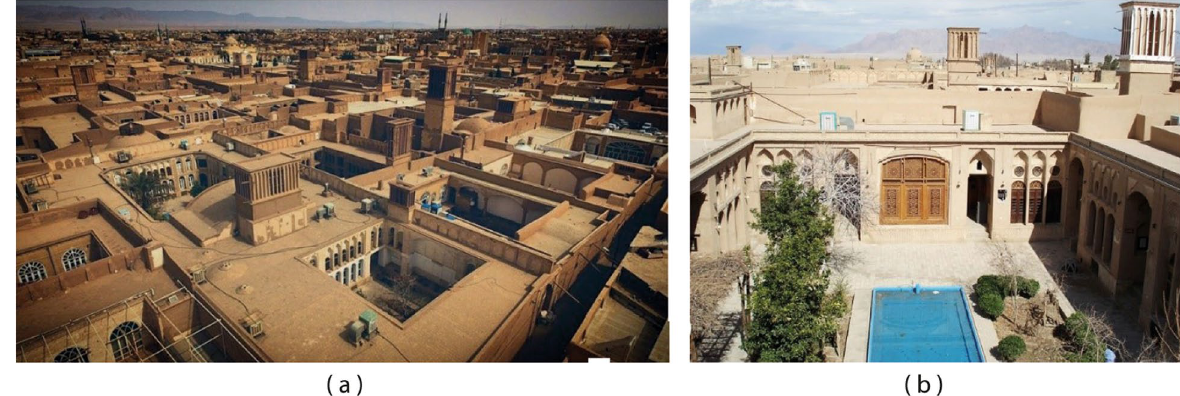
Fig. 5 Low‑rise adobe buildings in Yazd: ( a ) view of the city’s historic fabric (Source: Hoseini) and the ( b ) Lariha house (Source: the authors)